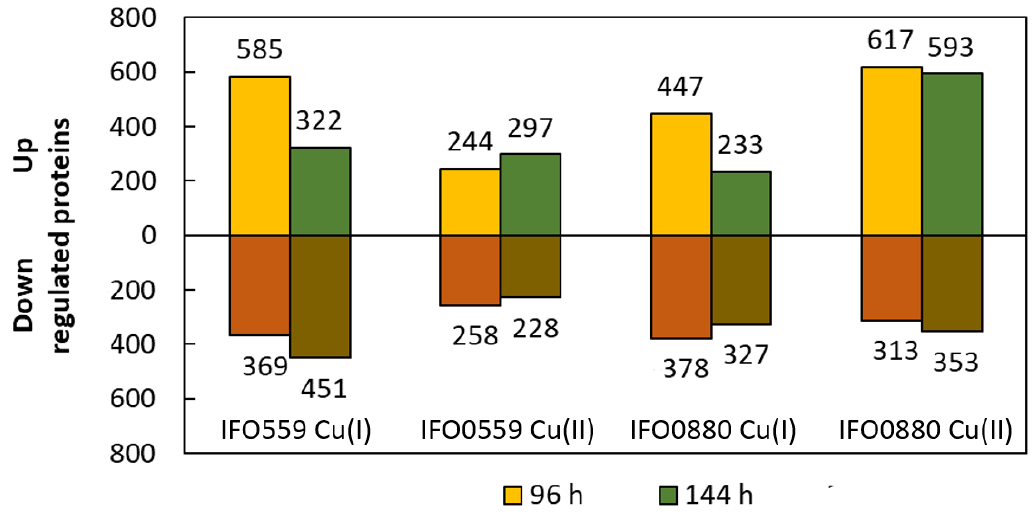
Figure 5. Summary of the proteins quantified with significantly different abundance between samples exposed to 0.5 mM Cu(I) or Cu(II) in comparison to control group, whereas ammonia served as control to Cu(I)-treated samples and 0 mM served as control to Cu(II)-treated samples, at two different time points, 96 h (yellow/red) and 144 h (green/brown). Significance ≥ 2, fold change ≥ 2, detected in at least one sample per group, LFQ by PEAKS Studio.